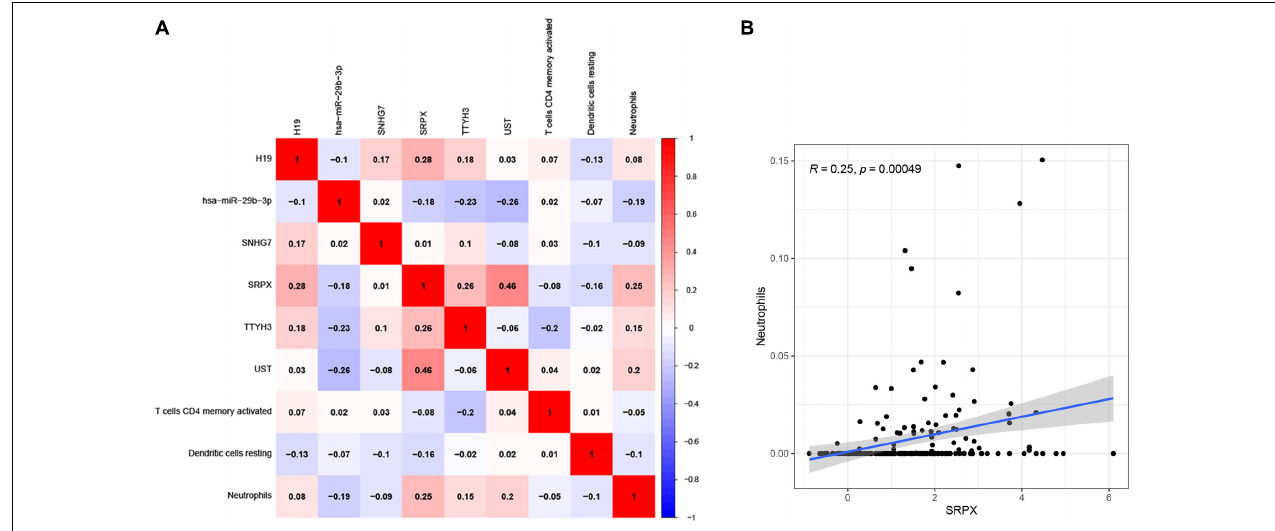
FIGURE 11 | Correlation test was performed to explorecorrelation between ceRNA prognostic model and infiltrating immune cells prognostic model (A) . The correlation matrix of the elements in two prognostic models. The correlation between Neutrophils and SRPX (B)